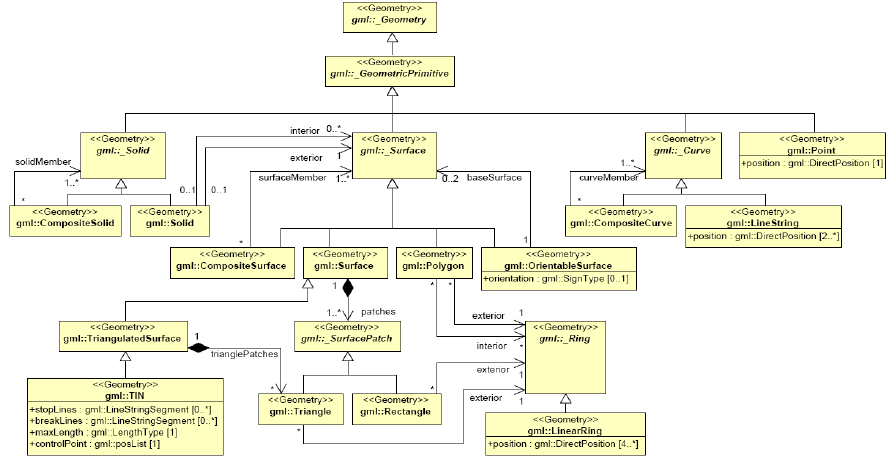
Figure1. UML diagram of CityGML geometry model (Primitives and Composites) [5]